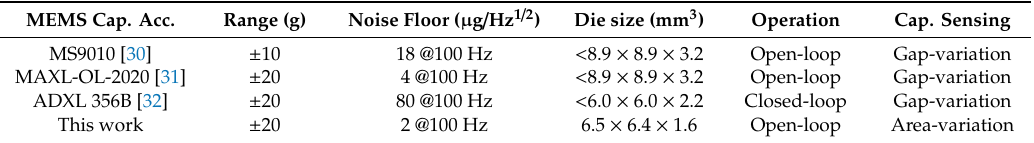
Table 4. Comparison of the proposed accelerometer with commercial o ff -the-shelf (COTS) MEMS capacitive